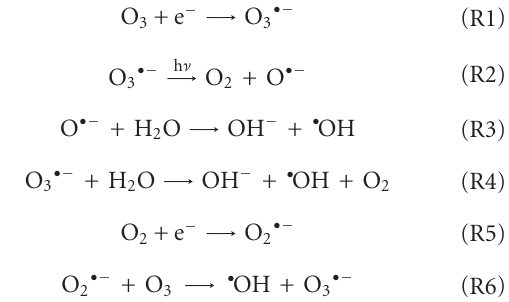
O 3 + UV 254nm or UV 254nm photocatalysis. For the ozone decomposition, all of these three noble metal NPs (Pt,